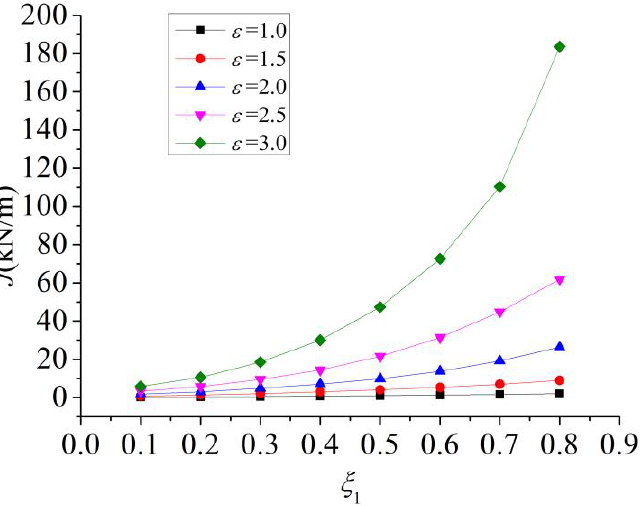
J  − curves for different eccentricities. Figure 20. J − ξ Figure 20. 1 curves for different 1